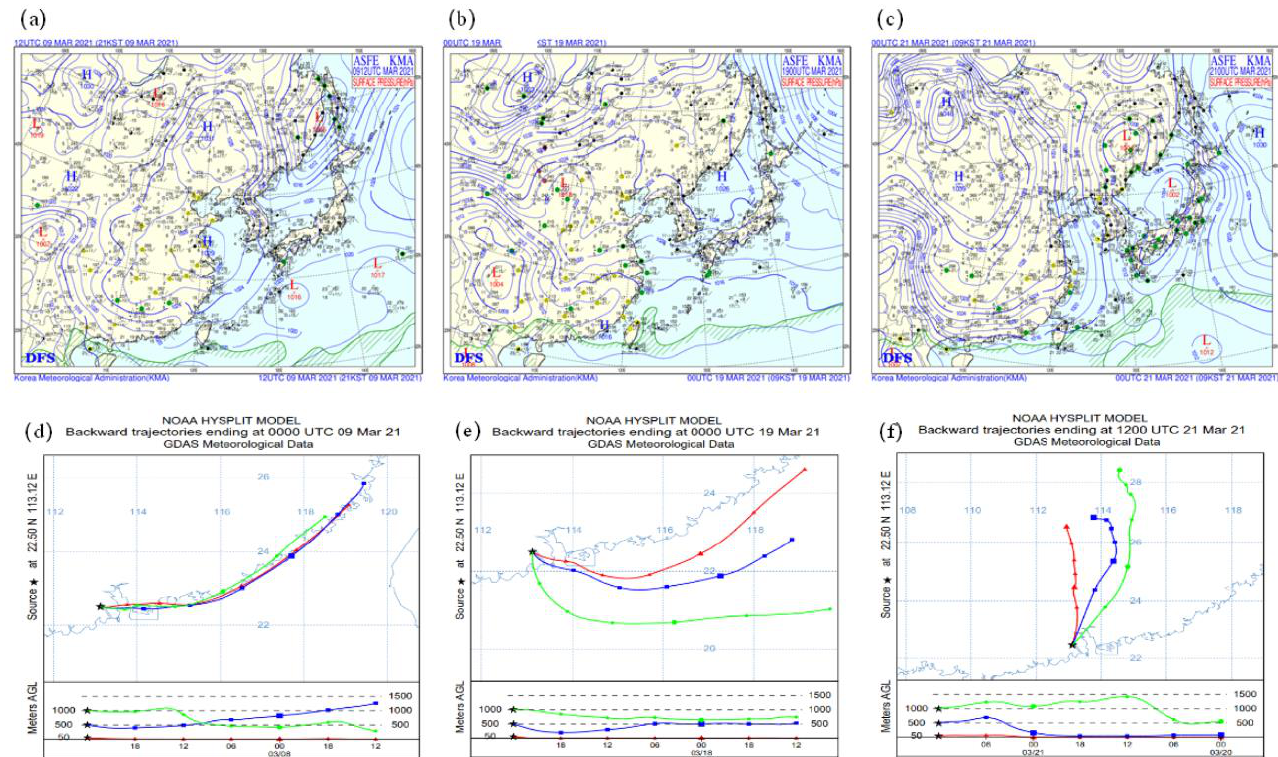
Figure 13. ( a – c ) Surface weather maps, ( d – f ) HYSPLIT 36h backward trajectories on 9, 19, and 21 March 2021 and the pentagram represents Zhuhai region.